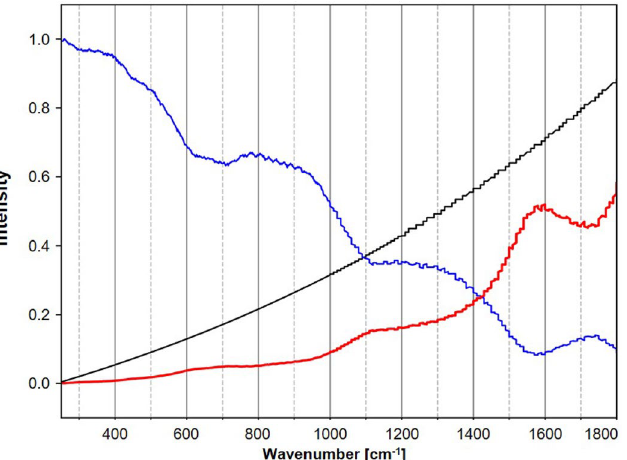
Figure 9. Reference spectrum of the white light source (black), the experimental spectrum of the white light source from the O-PTIR instrument (blue), and the calculated correction factor per wavenumber